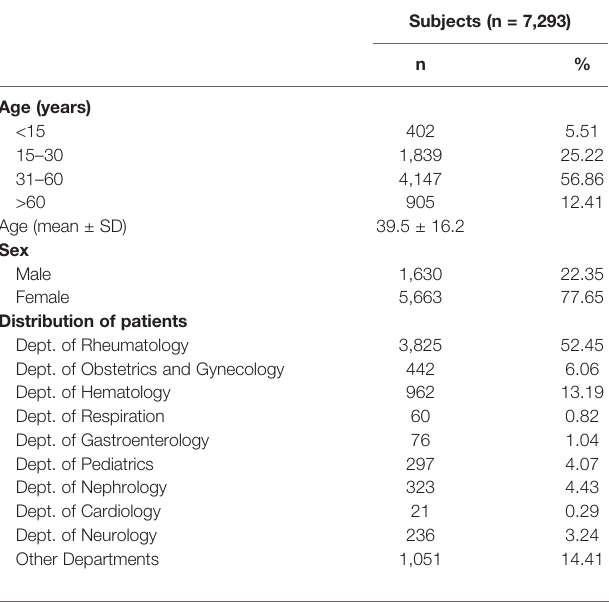
TABLE 1 | Demographic data of 7,293 consecutive subjects.